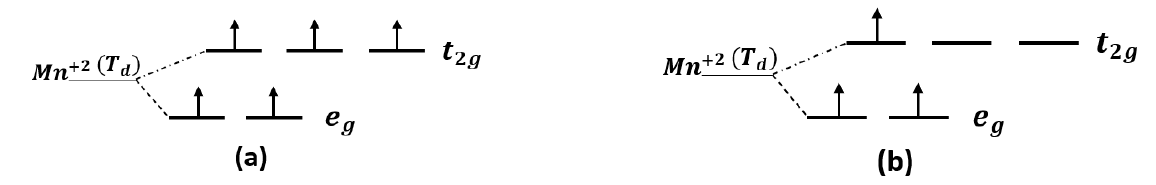
Figure 6. Geometrical spin orientation of Mn +2 ( a ) Mn +2 ( T d ) at ground state, ( b ) Mn +2 at silicon site of doped 3C-SiC, where T d indicated tetrahedral configuration.